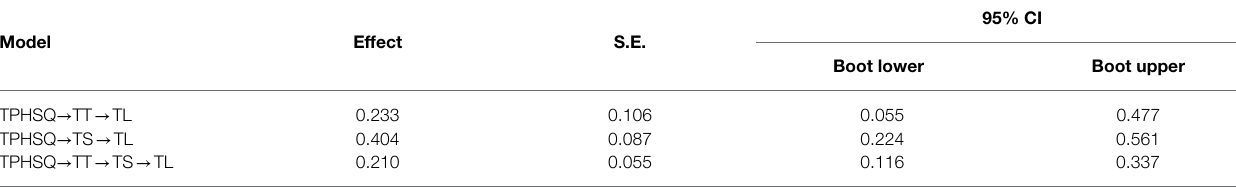
TABLE 6 | Regression coefficients of serial mediation models estimated using